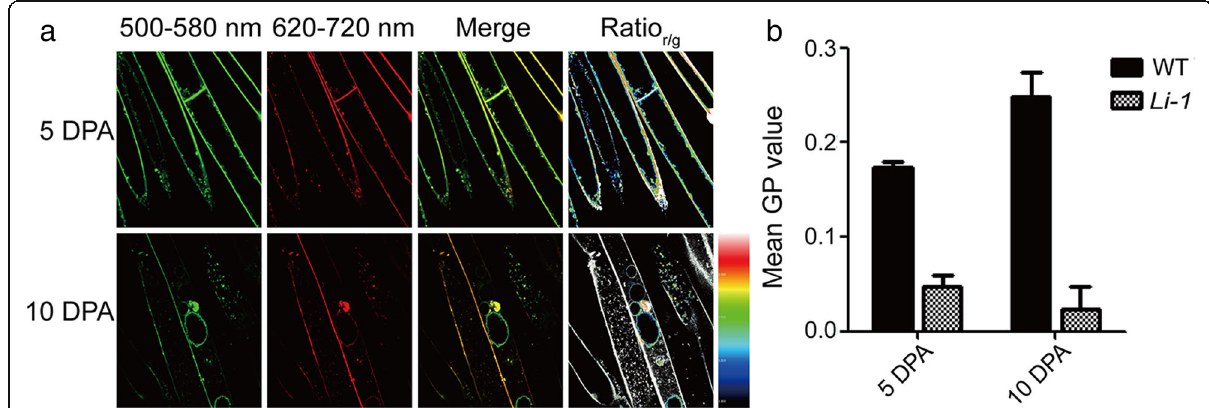
Fig. 6 Fluorescence images and the GP value of Li-1 mutant fibers. a Confocal laser scanning microscope images of di-4-ANEPPDHQ stained 5 DPA (top) and 10 DPA (bottom) Li-1 fibers. 500 – 580 nm, the green channel; 620 – 720 nm, the red channel; Merged, the merged channel of green and red channels; Ratio, the ratio images of red channel/ green channel. b The GP value of 5 DPA and 10 DPA wild-type and Li-1